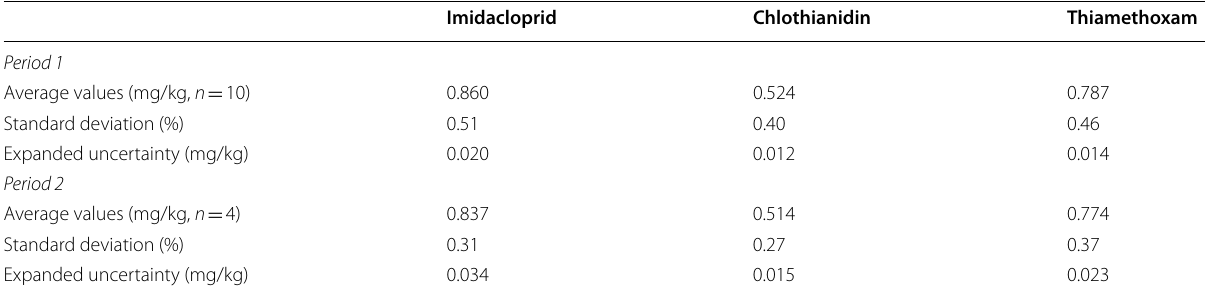
Table 2 Measurement values of kimchi cabbage reference materials by the developed ID-LC/MS/MS